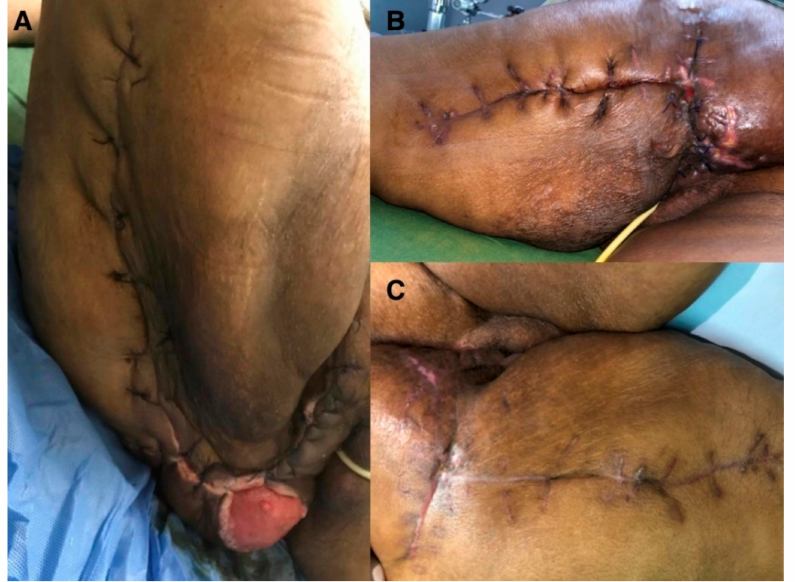
Figure 2. Clinical presentation of a massive Fournier’s gangrene after 15 days of management ( A ), after 39 days ( B ) and after 2 months ( C